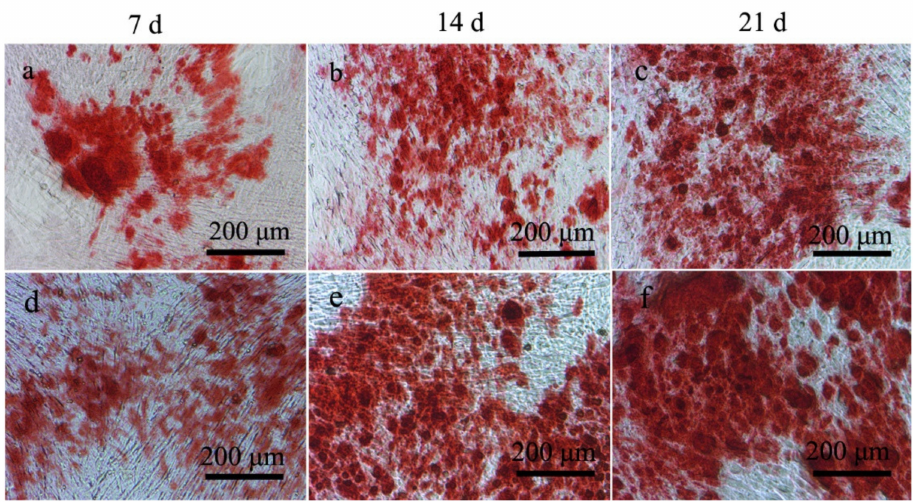
Figure 5. Results of the alizarin red staining assay for MC3T3-E1 cells after co-culturing with 3D rGO/PPY ( a – c ) and 3D rGO/PPY/Sr ( d – f ) composite scaffolds at 7, 14, and 21 d,